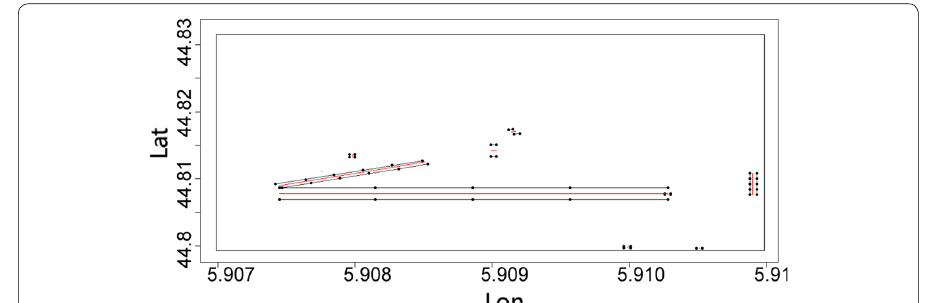
Fig. 8 Waypoints along network lines. δ represents the distance from a line for subregions covered by a